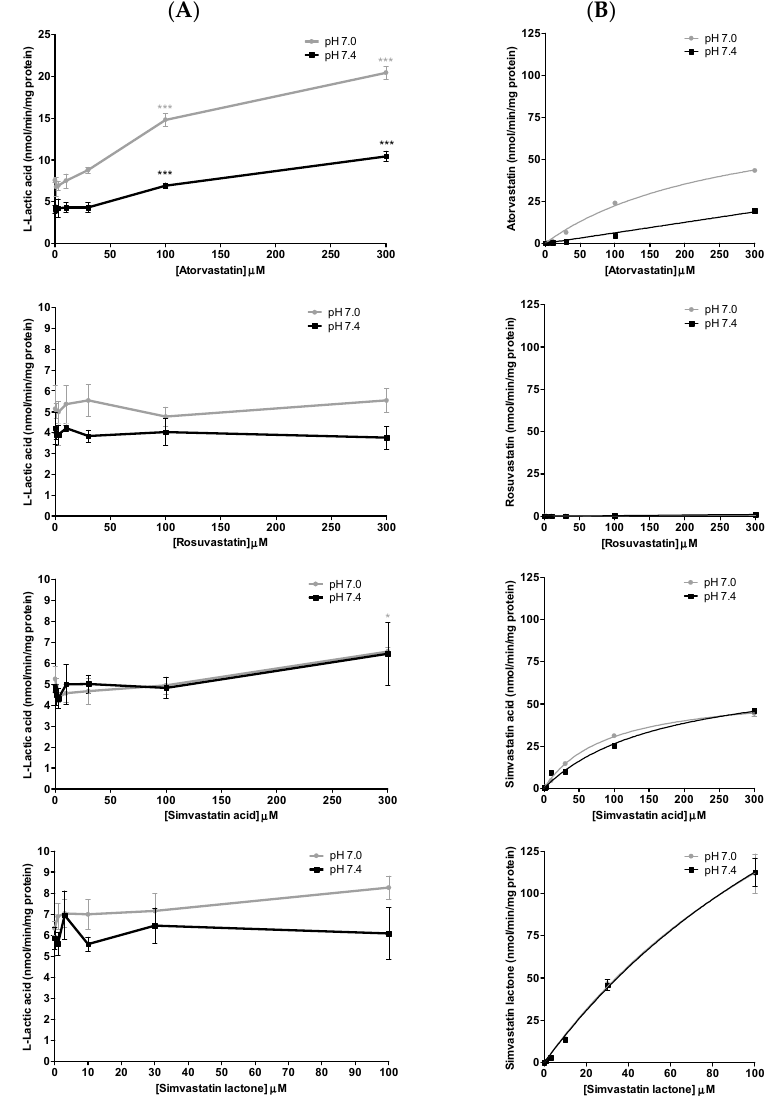
Figure 5. Drug inhibition studies with statins in SkMC. ( A ) Inhibitory effects of different statins (atorvastatin, rosuvastatin, simvastatin hydroxy acid and simvastatin lactone) on L -lactic acid (6 mM) efflux in SkMC. The residual intracellular [ 14 C] L -lactic acid was measured after 2.5 min of efflux at pH 7.0 and pH 7.4. ( B ) Intracellular concentrations of statins (atorvastatin, rosuvastatin, simvastatin hydroxy acid and simvastatin lactone) at the end of inhibition assays in SkMC at pH 7.0 and pH 7.4. Each point represents the mean ± S.D. of experiments performed in triplicate (* p < 0.05, ** p < 0.01 and *** p < 0.001).